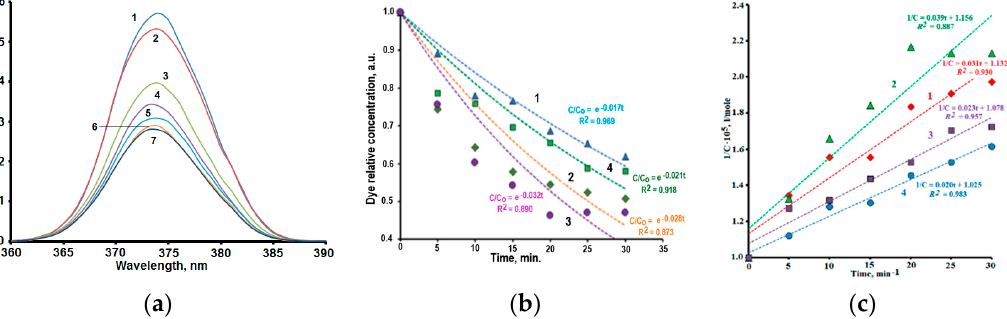
Figure 5. ( a ) Changes in absorption spectra of Rhodamine 6G solution containing powder sample 2 under UV irradiation. Irradiation duration, min.: 0 (curve 1); 5 (curve 2); 10 (curve 3); 15 (curve 4); 20 (curve 5); 25 (curve 6); 30 (curve 7); ( b ) kinetics of dye photodecomposition under UV radiation in solutions containing powder samples 1 (curve 1); 2 (curve 2); 3 (curve 3); 4 (curve 4); ( c ) dependencies 1/C = f(t) drawn for the dye photodecomposition in solutions containing powder samples.